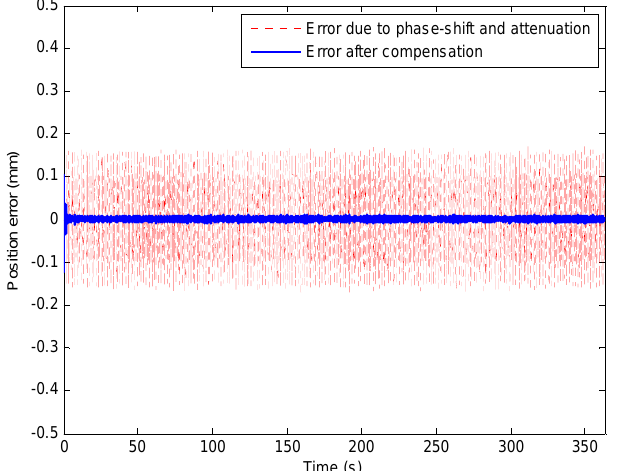
Figure 11. Position estimation error with the high-pass filter and the proposed method.